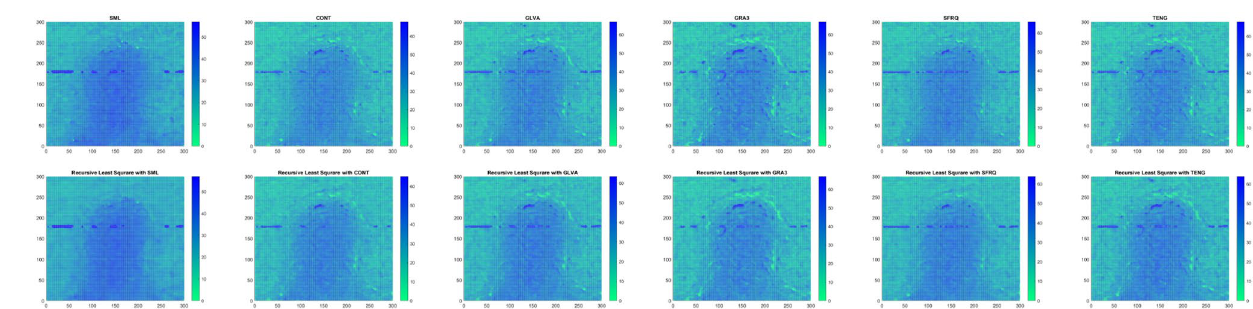
Figure 15. Shape reconstruction of Coin using FM with proposed RLS method. (left to right), SML, CONT, GLVA, GRA3,SFRQ, TENG. (top row) with FM only and (bottom row) using FM with RLS